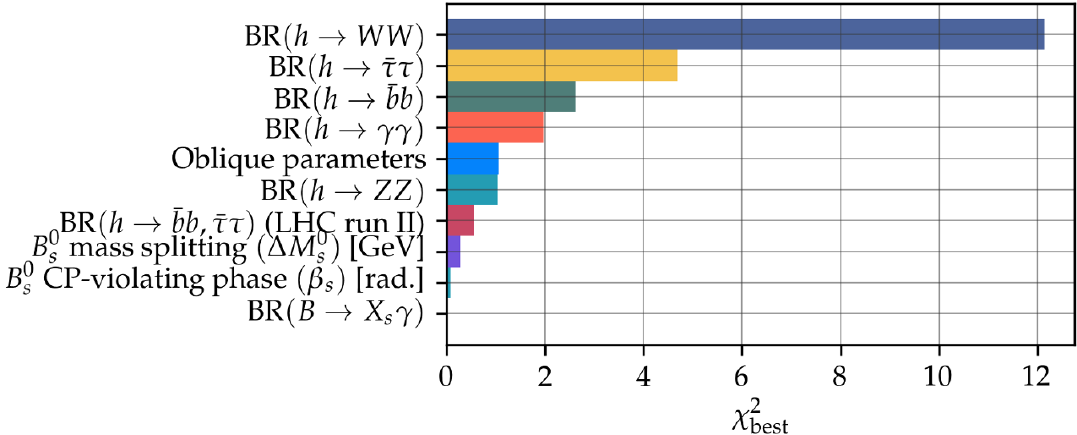
Figure 8 . The contributions from each of the constraints to the best-(cid:12)t (cid:31) 2 in our global scan of the